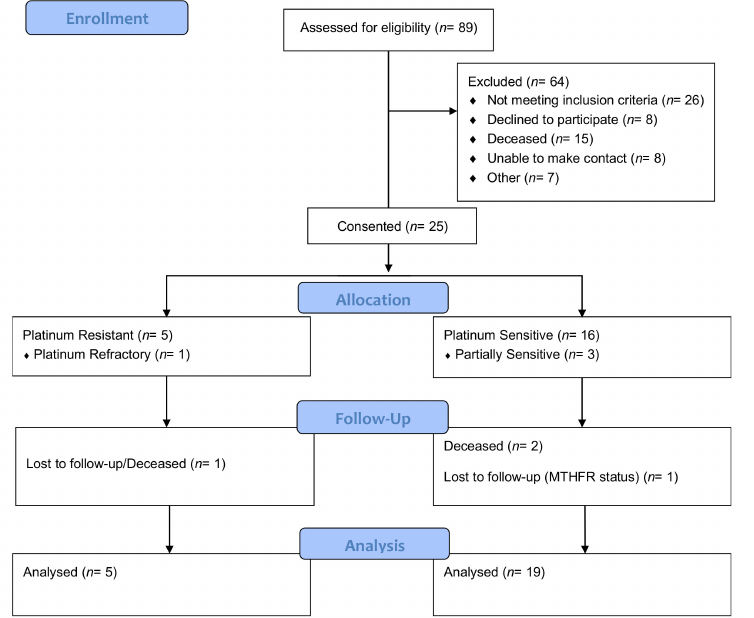
Figure 1. Consort flow diagram: participant inclusion and exclusion at each stage of the trial.